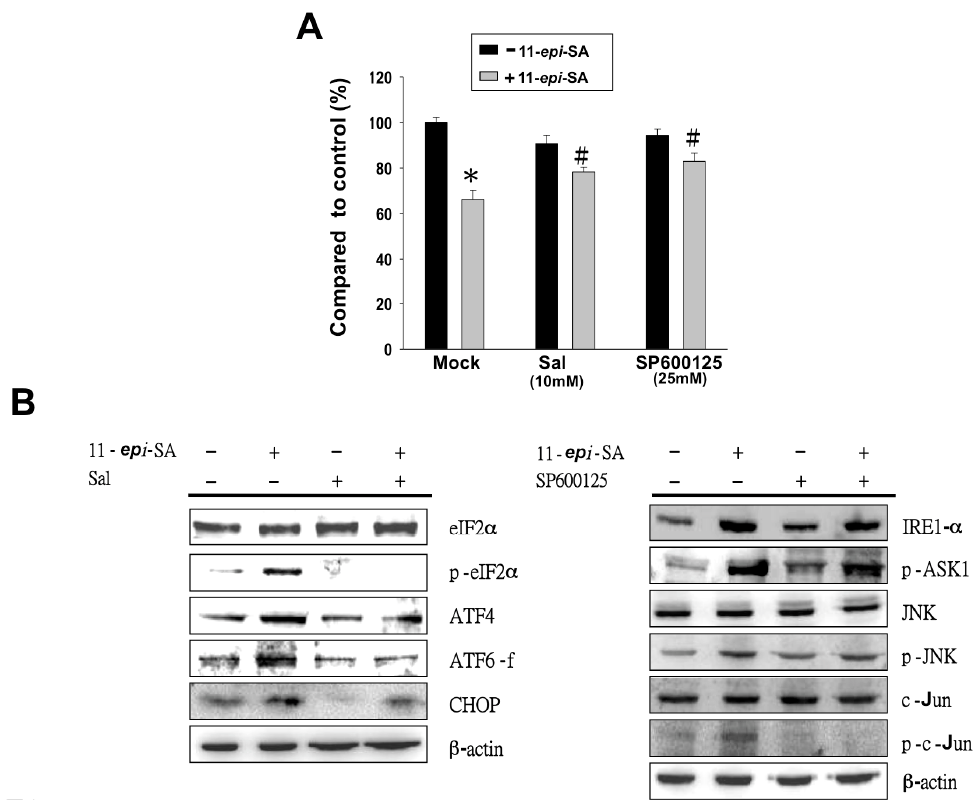
Figure 9. Treatment with 11- epi -SA induces HA22T cell apoptosis through two distinct pathways. ( A ) Two inhibitors, salubrinal (Sal) and SP600125, rescued the 11- epi -SA-induced cytotoxicity in HA22T cells. # p < 0.05; * p < 0.001; ( B ) Validation of altered protein expression caused by these two inhibitors. HA22T cells were treated with 11- epi -SA in the presence or absence of Sal ( left ) or SP600125 ( right ) for 24 h, cells were harvested and cell lysates were processed to assess ER stress-mediated pathways proteins as indicated by Western blotting using specific antibodies as indicated.